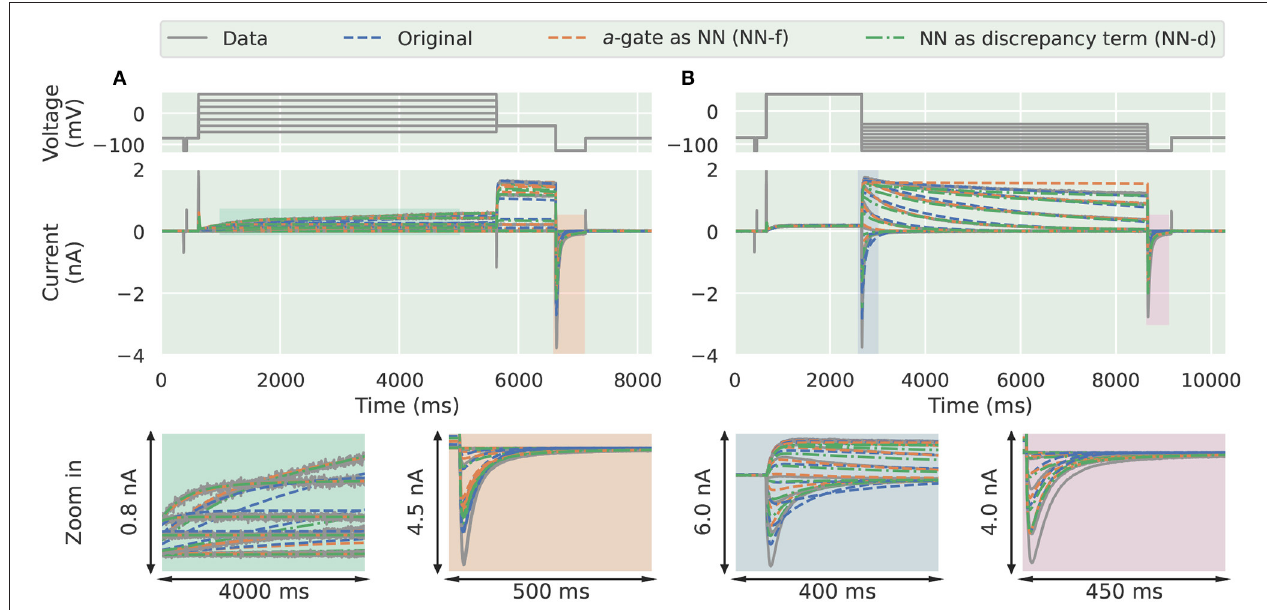
FIGURE 5 | Training results for the experimental data from Beattie et al. (2018). Comparison of the experimental data (grey) against the candidate a -gate model (blue), the a -gate modelled using a neural network (NN-f, orange), and the a -gate with a neural network discrepancy term (NN-d, green). (A) Shows the activation steady-state protocol (Pr3) and (B) shows the deactivation time constant protocol (Pr5). All figures with a green background are real data examples.